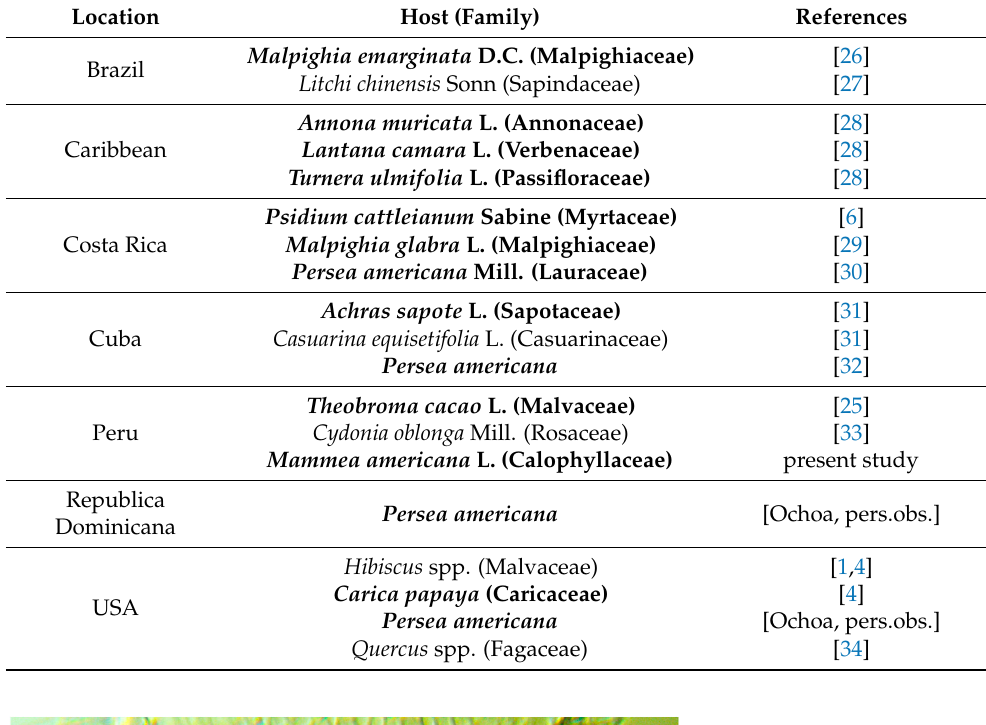
Table 2. Tuckerella pavoniformis in the Americas—distribution and host plants (hosts in bold are endemic to the Americas).